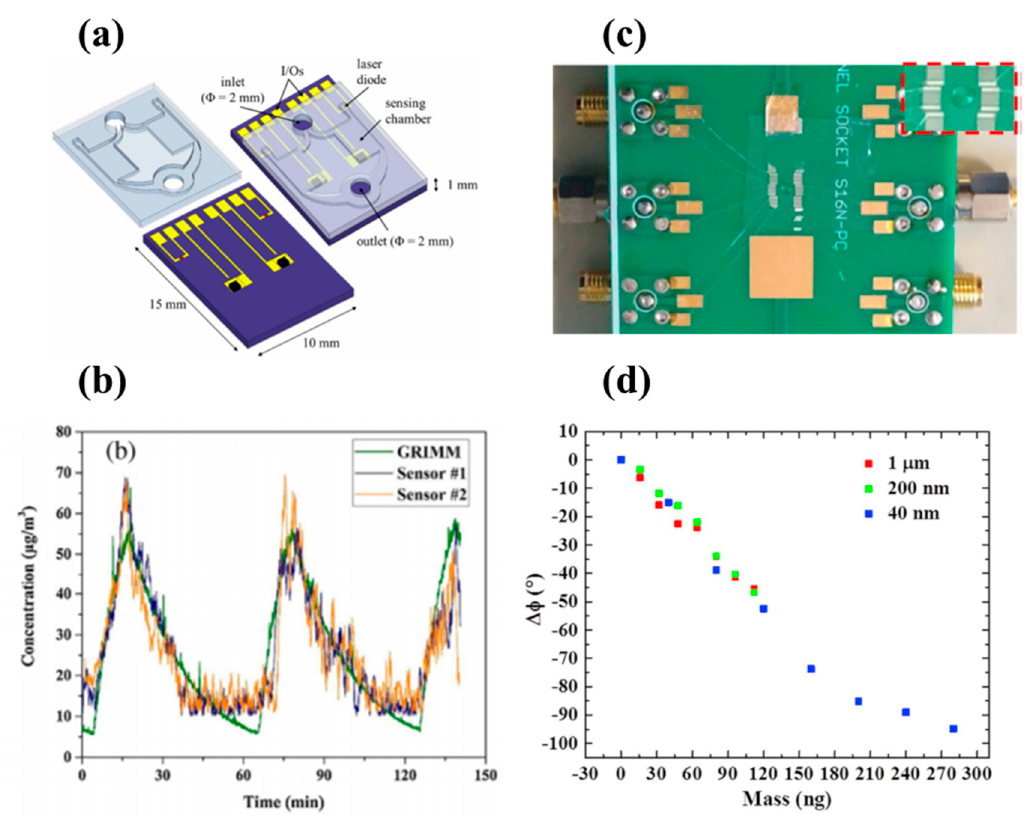
Figure 1. ( a ) Schematic of a light scattering − based sensor and ( b ) its relative representative reading (reproduced from [12]). ( c ) Surface acoustic wave (SAW) delay lines connected to a printed circuit board and ( d ) relative phase shifts as a function of mass for particles of different diameter size (reproduced with permission from [14]).